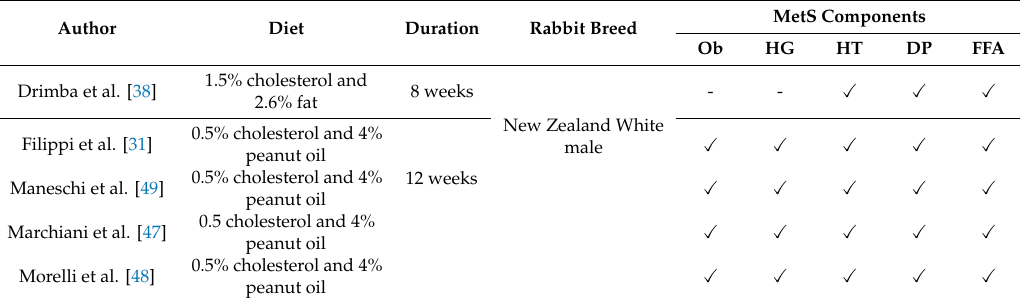
Table 2. E ff ects of diets supplemented with cholesterol on the development of MetS (metabolic